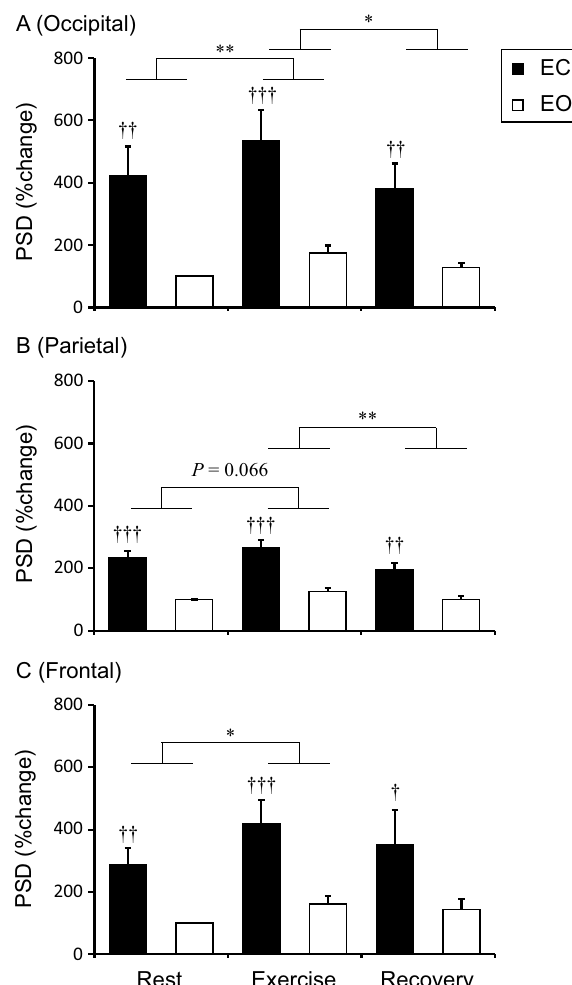
Figure 1. Alpha power spectrum densities in occipital (A) , parietal (B) , and frontal (C) site at the rest, exercise, and recovery periods. The values indicate the percentage change from Rest + EO and are shown as the mean ± standard error (N = 15). * p < 0.05, ** p < 0.01. † p < 0.05, †† p < 0.01, ††† p < 0.001 vs EO. PSD power spectrum